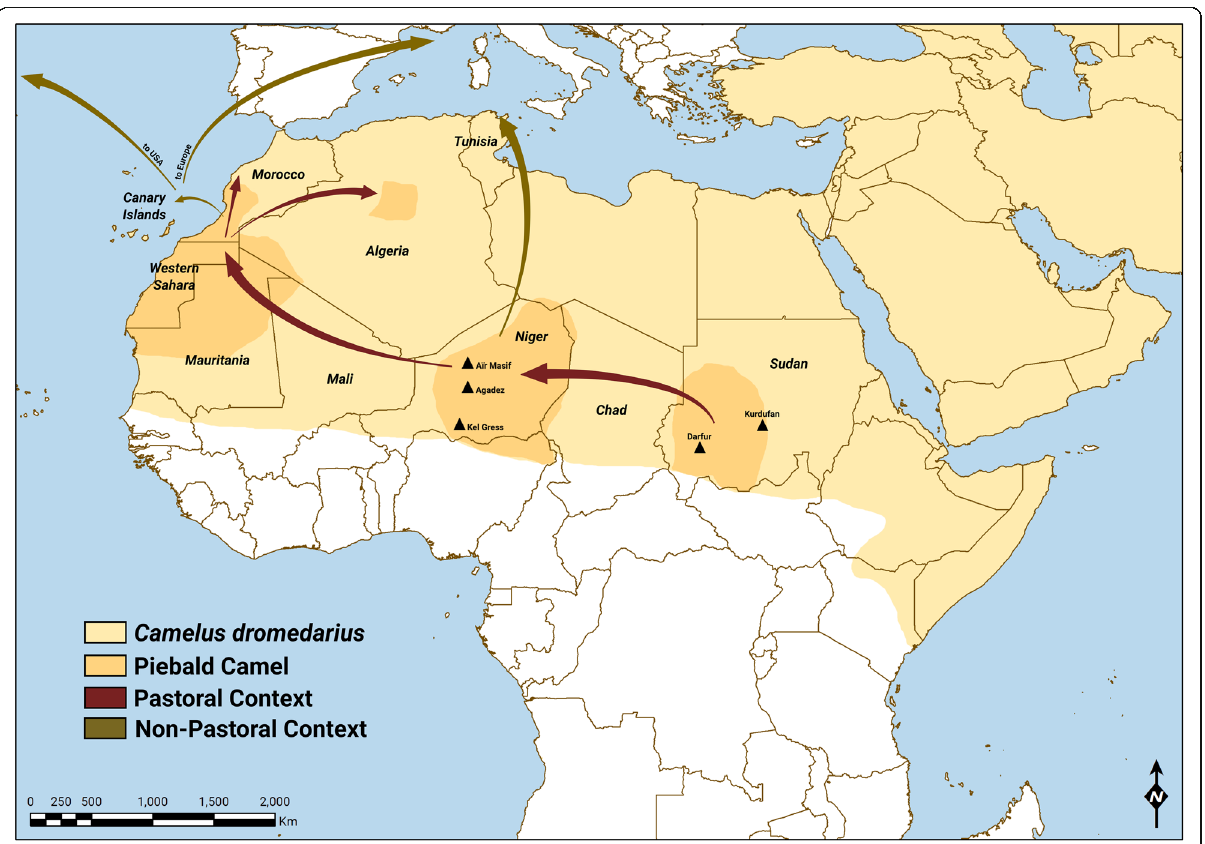
Figure 8 Areas of the world and names of the populations where contemporary breeding of piebald camels takes place (camel range is shown in softer tone